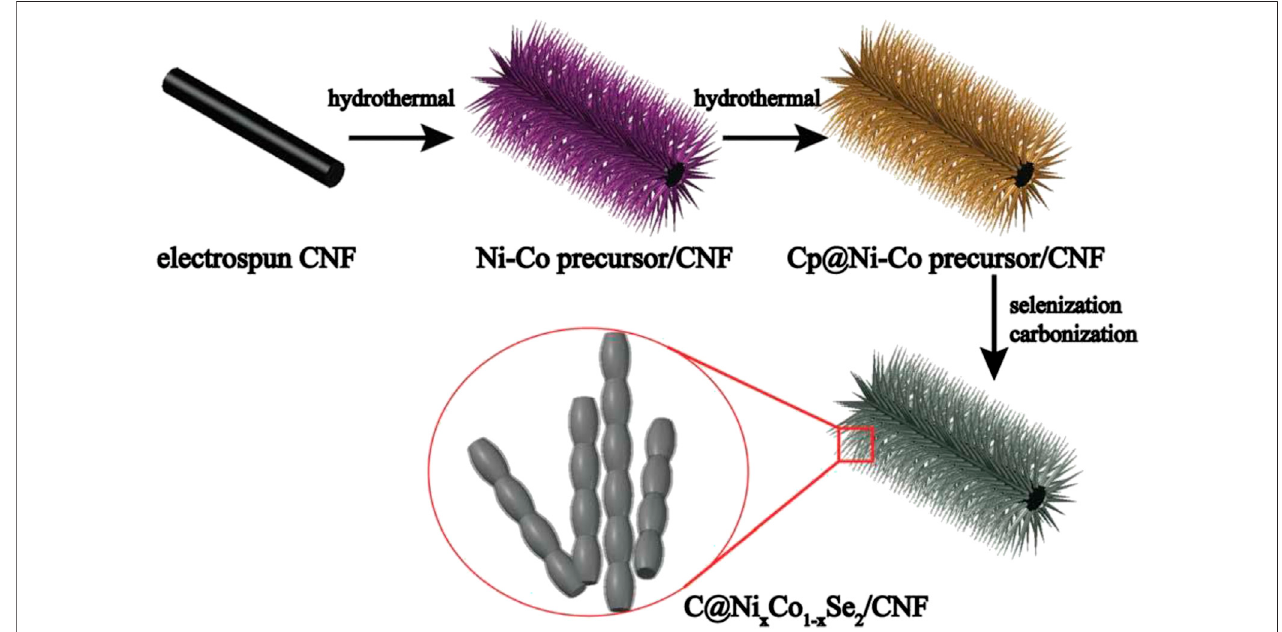
FIGURE 7 | Schematic illustration of the preparation of C coated bimetallic selenides anchored on CNFs.